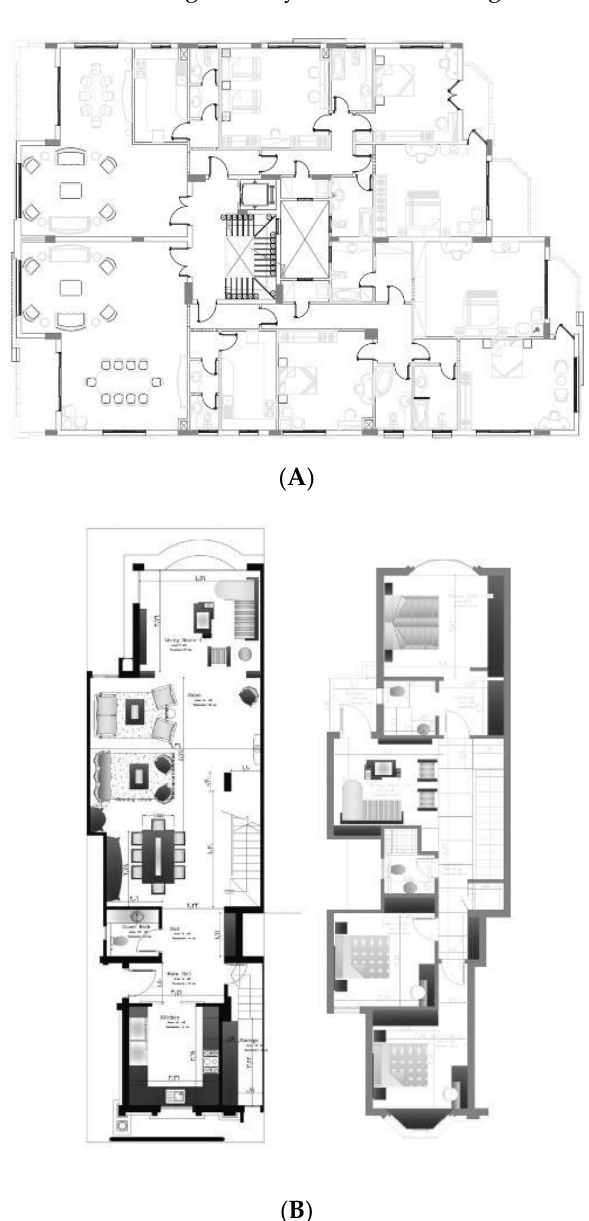
Figure 2. Floor plan example for ( A ) apartment dwelling and ( B ) single-family dwelling.